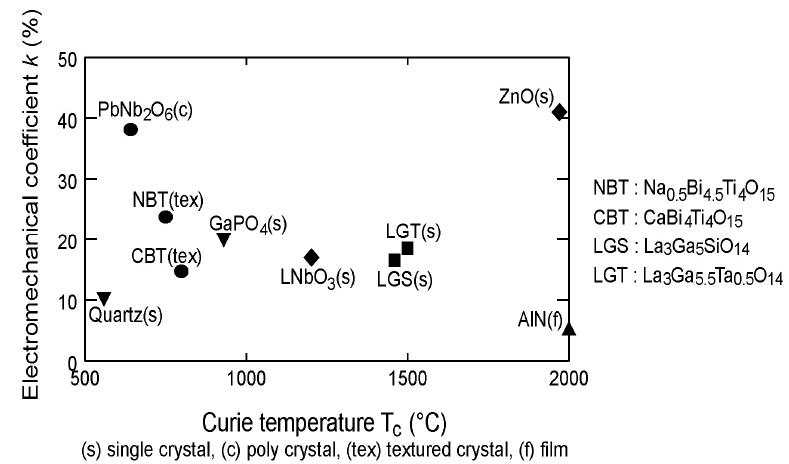
Figure 5. Electromechanical coefficient versus Curie temperature T c [10].